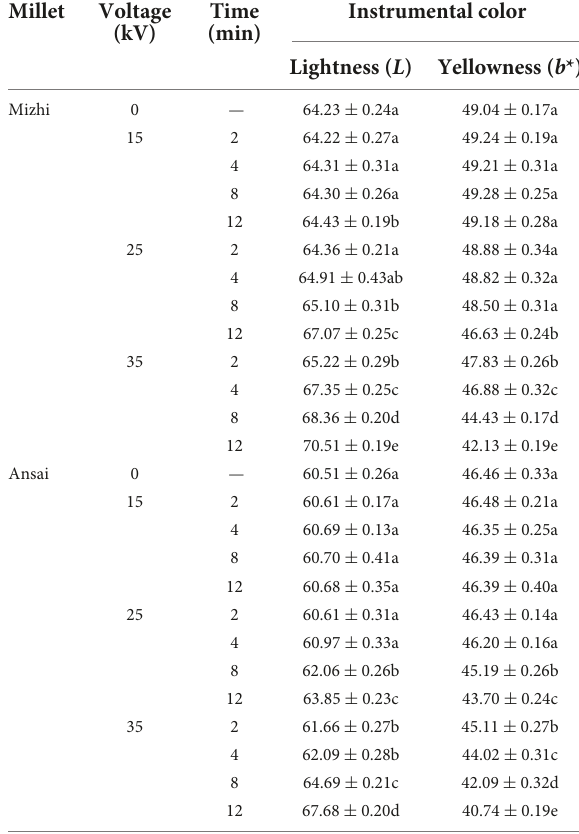
TABLE 1 Effect of DBD-ACP on color indexes of foxtail